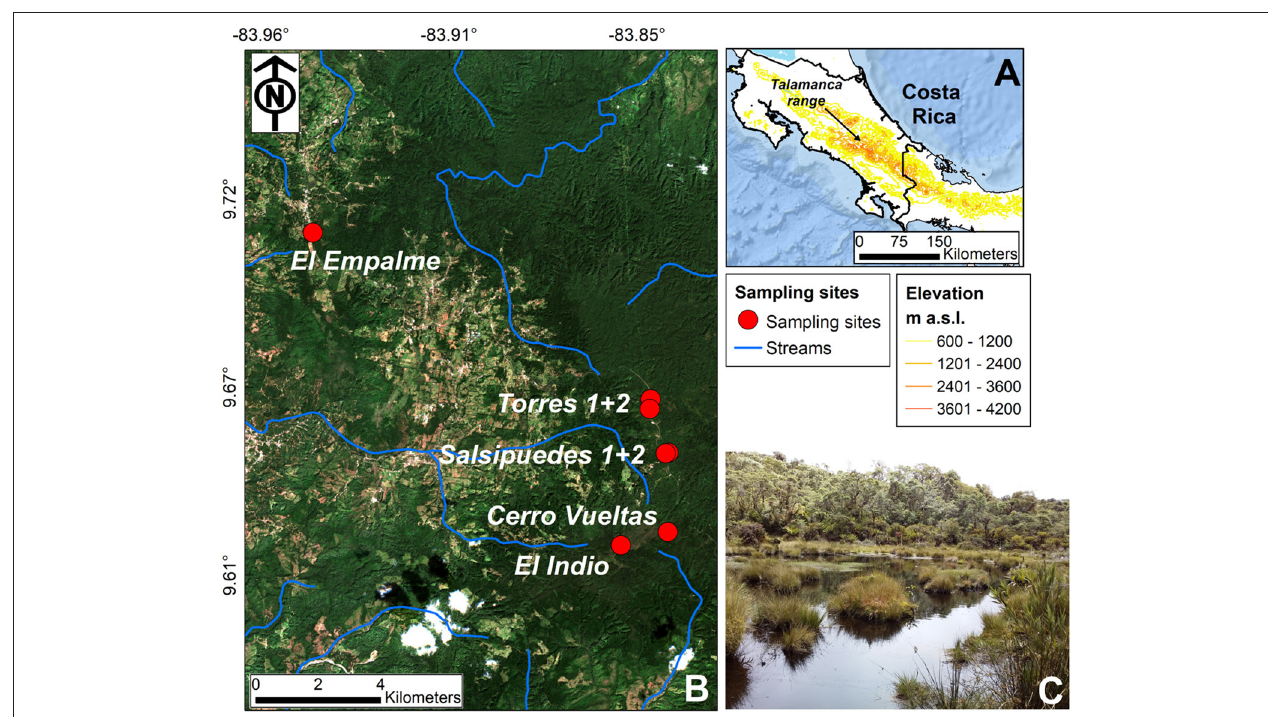
FIGURE 1 | (A) Talamanca range overview and elevation gradient of Costa Rica. (B) Landsat image of the peatland study area (also known as Turberas de Altura ) within the high elevation Páramo ecosystem, including site locations and main streams. (C) Typical peatland condition throughout the wet season. El Empalme y El Indio represent the lowest and highest sampling sites,